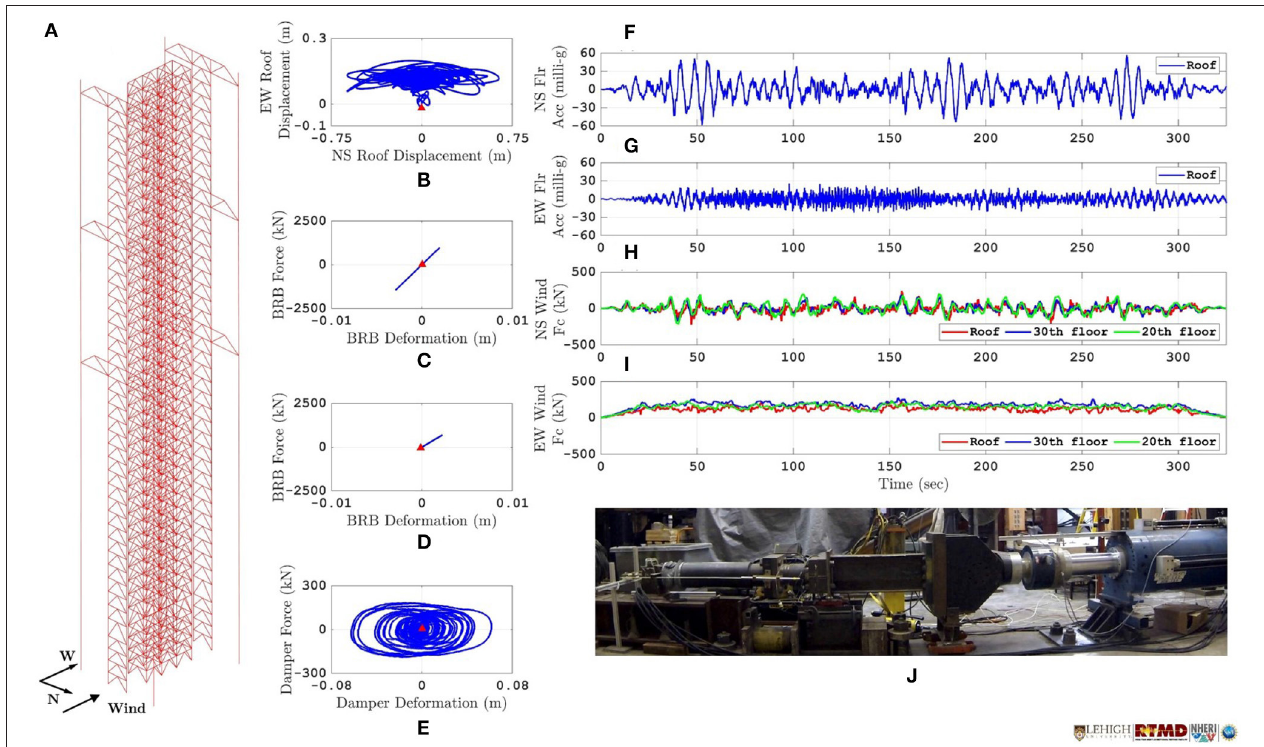
FIGURE 11 | The 3D RTHS of a tall building equipped with non-linear viscous dampers under wind excitation: (A) isometric view of structure, (B) bi-directional roof displacement orbits, (C,D) 1st story brace hysteresis in the NS and EW directions, (E) force-displacement hysteresis of the NLVD experimental substructure, (F,G) floor displacement time histories of selected floor levels, (H,I) bi-directional wind loading at selected floor levels, and (J) experimental substructure (full-scale NLVD).